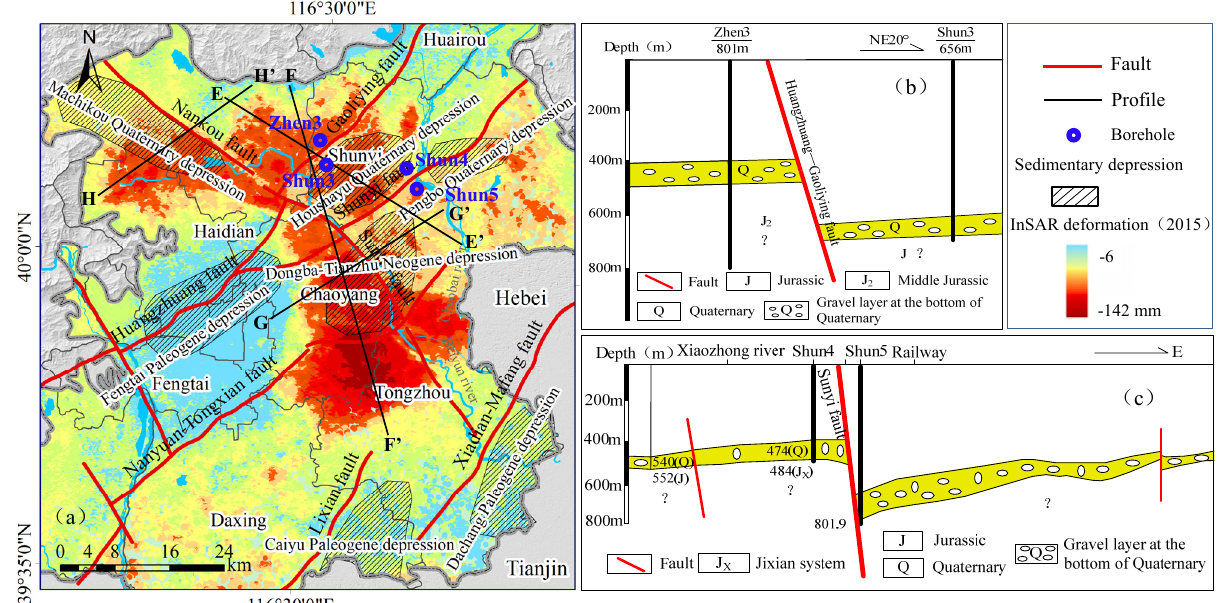
Figure 10. Basement structure and land subsidence distribution, and borehole profiles on both sides of the fault. ( a ) Main active faults and distribution of land subsidence in 2015. ( b ) Drilling section on both sides of Huangzhuang-Gaoliying fault. ( c ) Drilling profile on both sides of the Shunyi